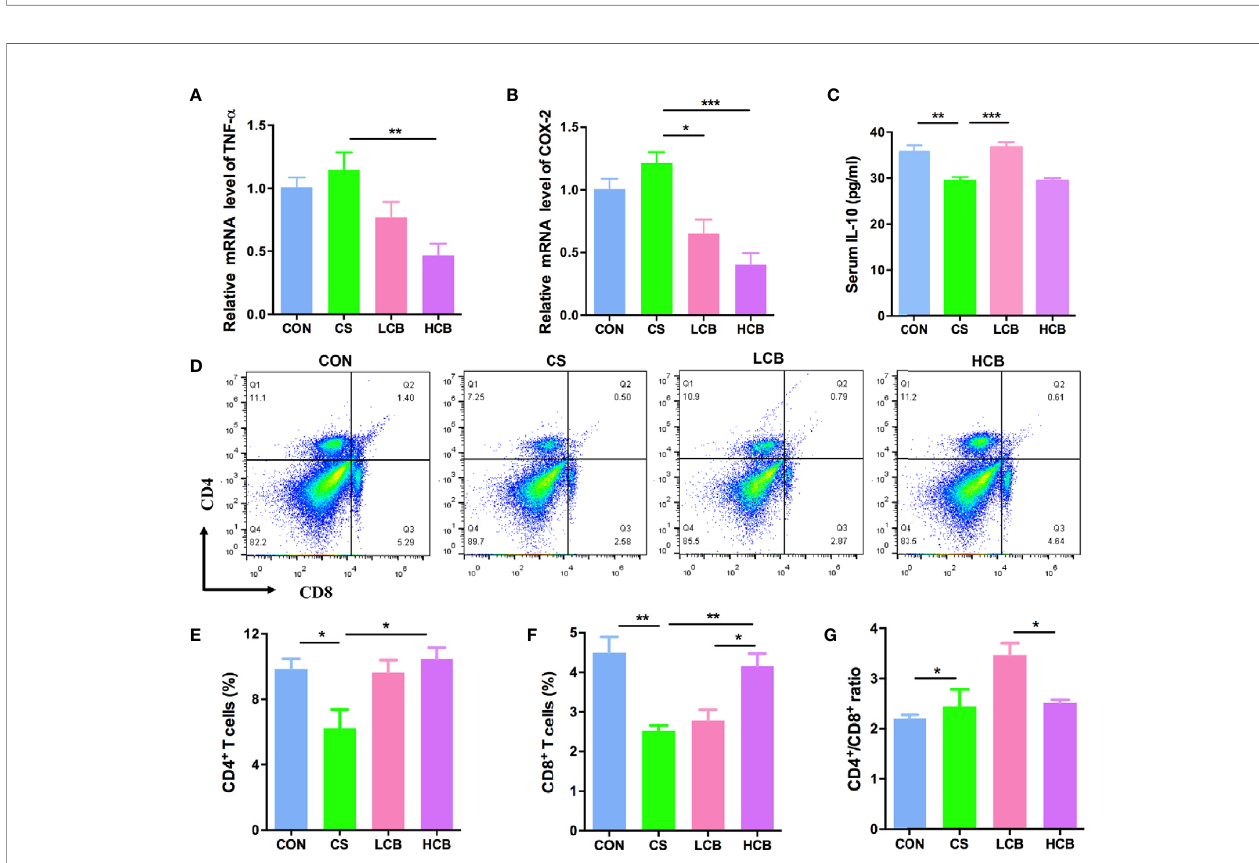
FIGURE 5 | Anti-in fl ammatory effect of CB RH2 on mice with ceftriaxone-induced intestinal dysbacteriosis. (A, B) The relative RNA expression of genes encoding tumor necrosis factor alpha (TNF- a ) and cyclooxygenase-2 (COX-2) in colon tissues of mice (n = 5); (C) IL-10 of serum were detected by ELISA following the manufacturer ’ s protocol (n = 5); (D) Representative fl ow cytometry plots of CD4 + and CD8 + T cells identi fi ed (n = 3); (E, F) Percentage of CD4 + and CD8 + T cells in spleen; (G) The proportion of CD4 + /CD8 + . All data were evaluated as mean ± SEM, *p <0.05, **p <0.01, ***p <0.001.